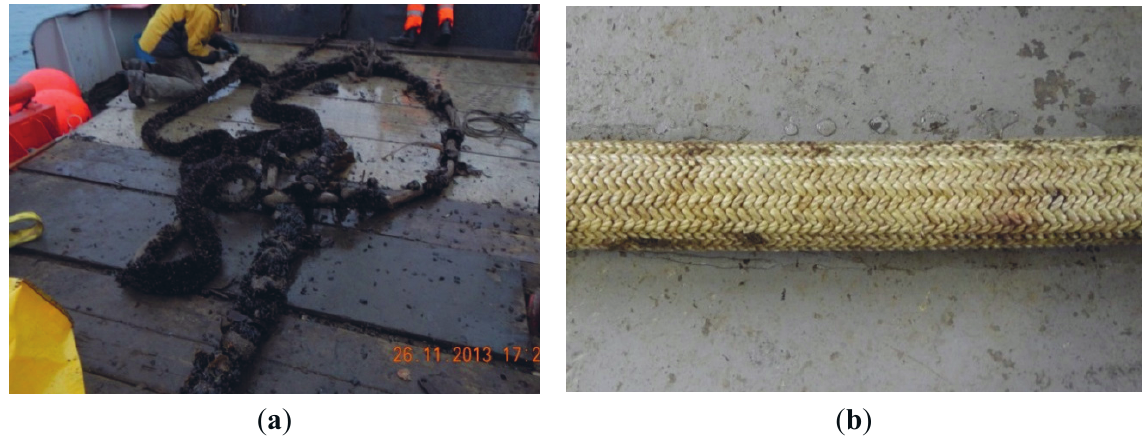
Figure 14. ( a ) Upper tethers with mussel growth; ( b ) P1-8 tether after